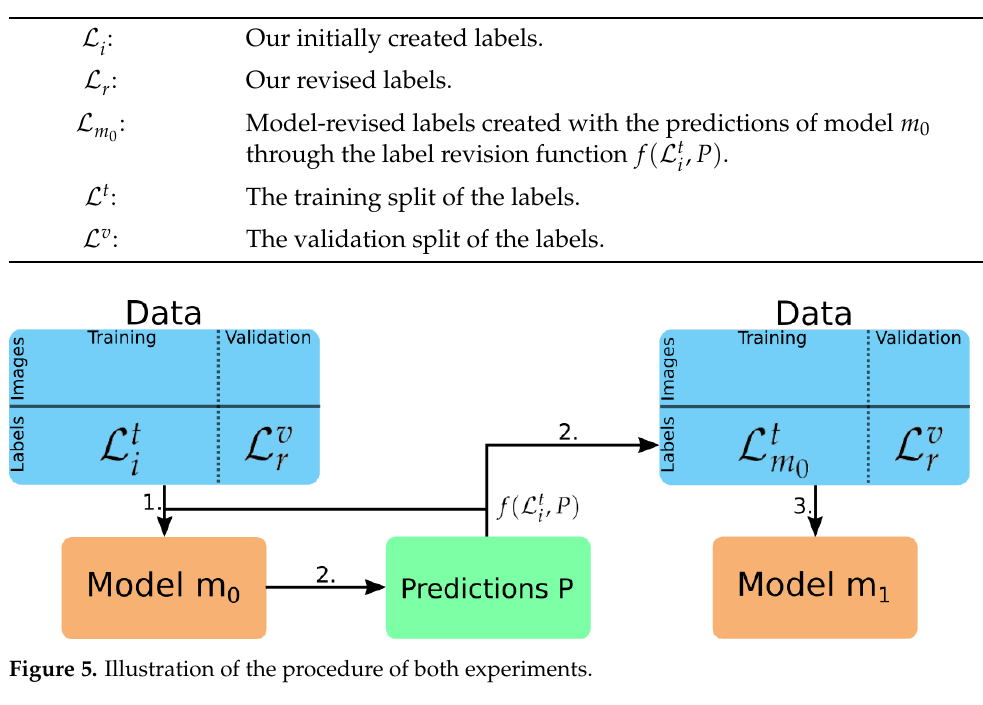
Table 1. Summary of the different labels for clarity.